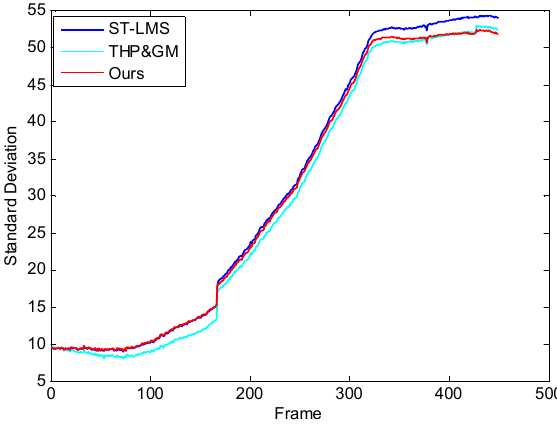
Figure 14. Standard deviation (SD) performance of the tested algorithms.